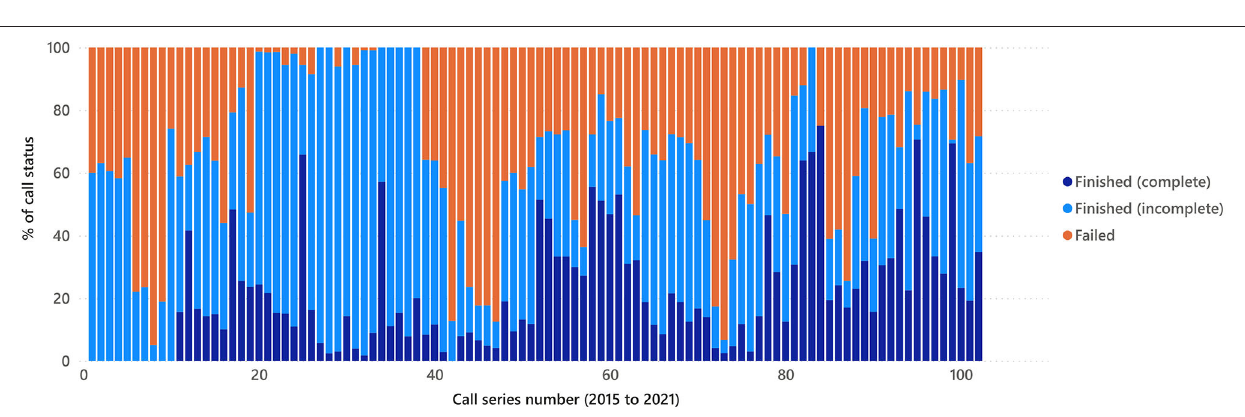
FIGURE 4 | Call status per series of calls, including the number of reached blocks per call.